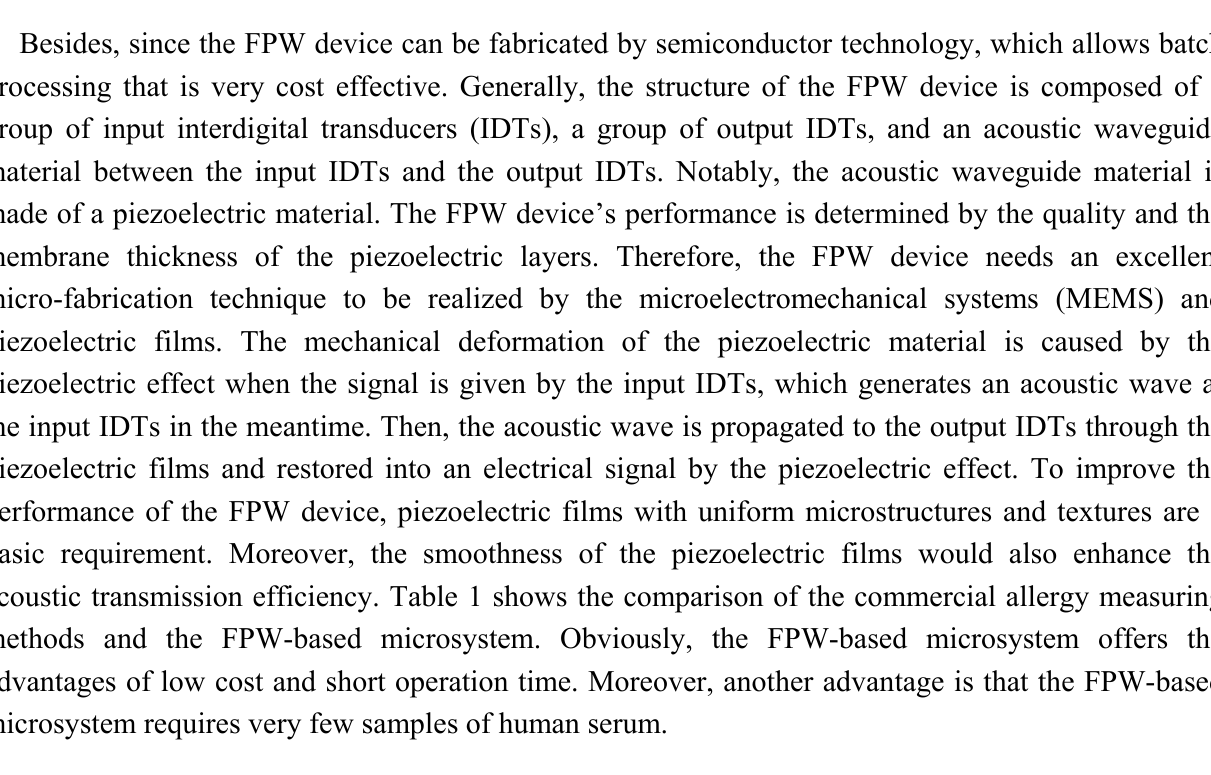
Table 1. Comparison with commercial allergy detectors and the proposed FPW-IgE microsystem. Abbot ELSA CLIA